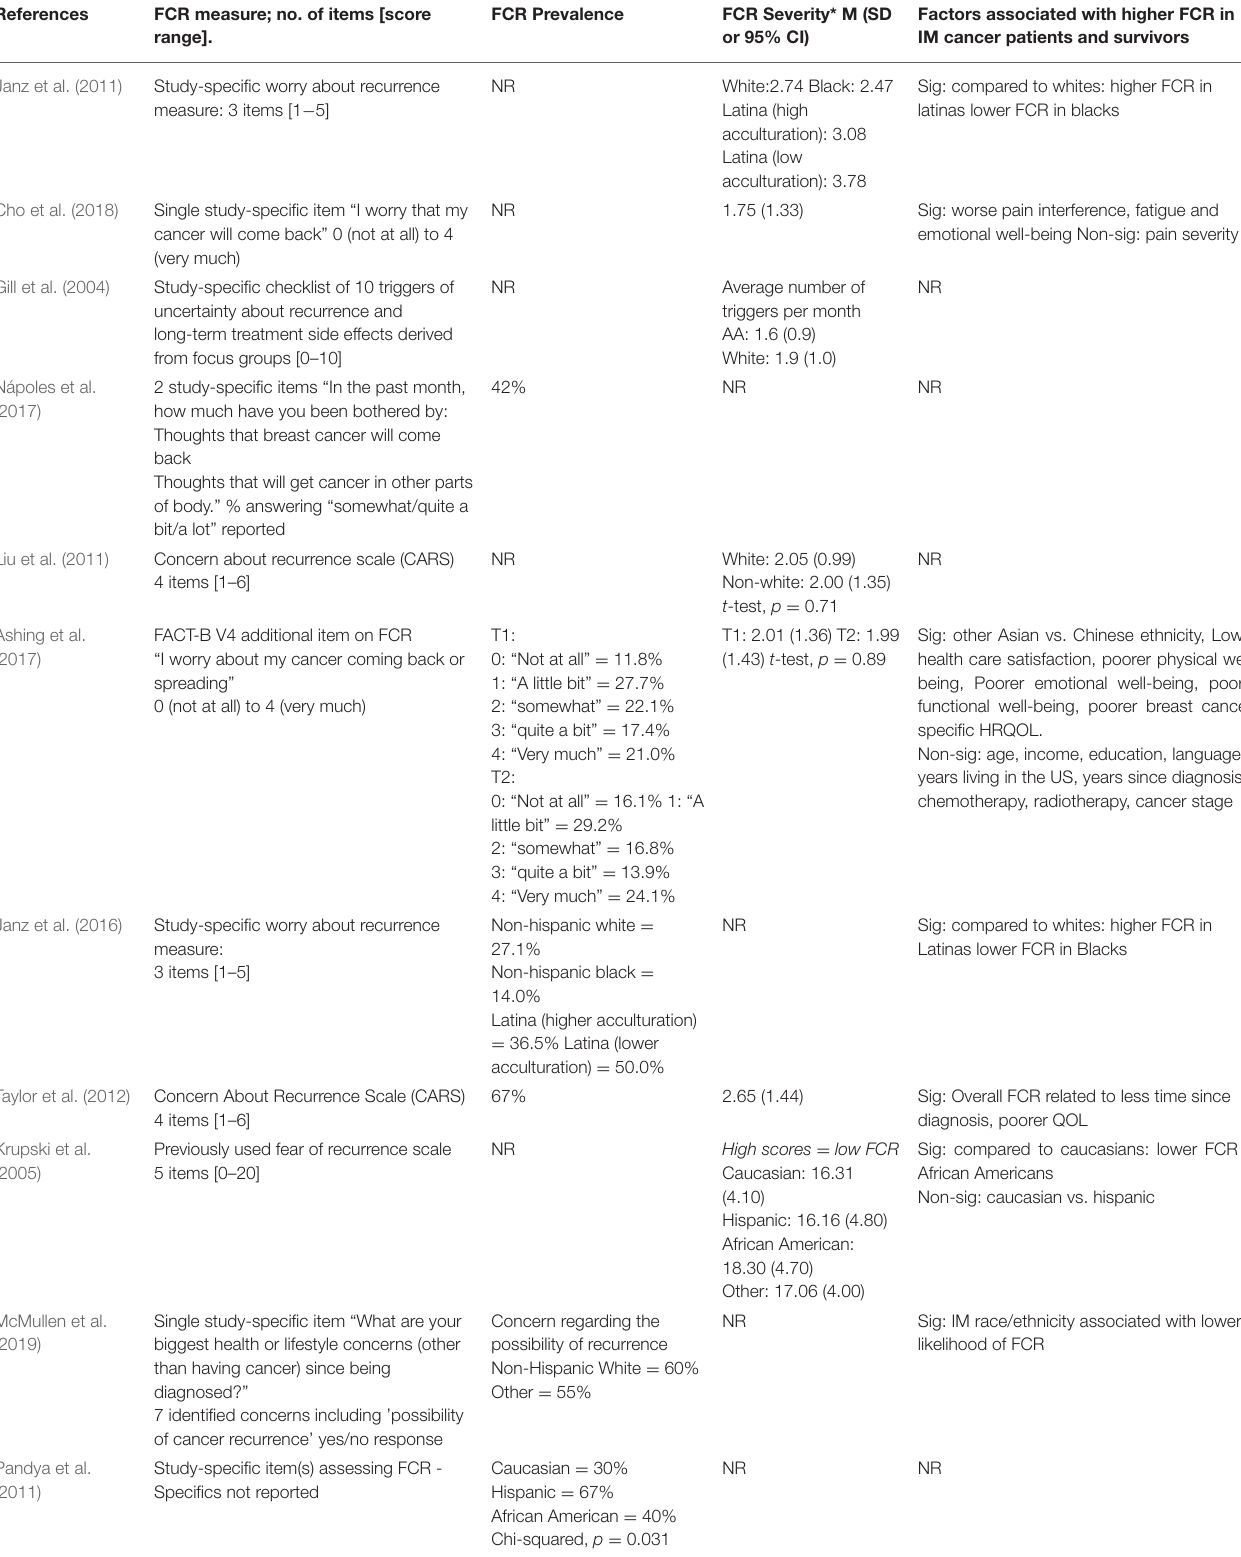
TABLE 3 | Results from quantitative